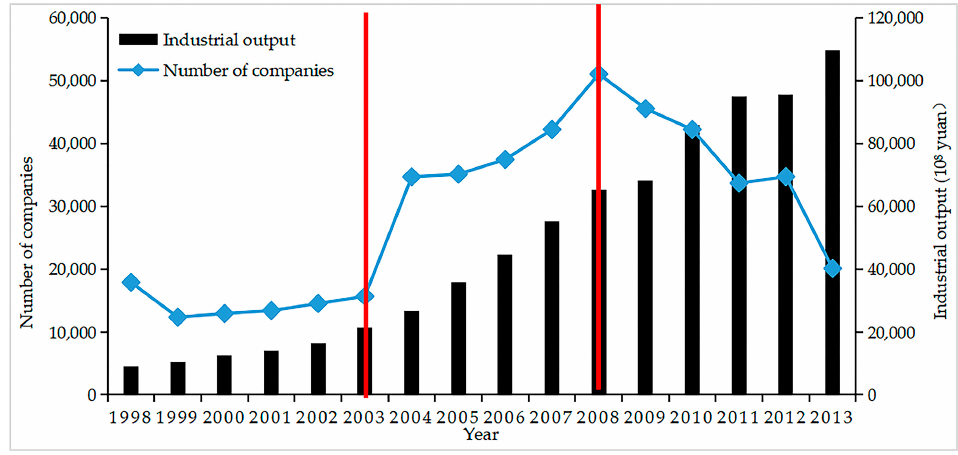
Figure 2. Changes in the Total Industrial Output Value and the Number of Industrial Enterprises in Guangdong from 1998 to 2013.